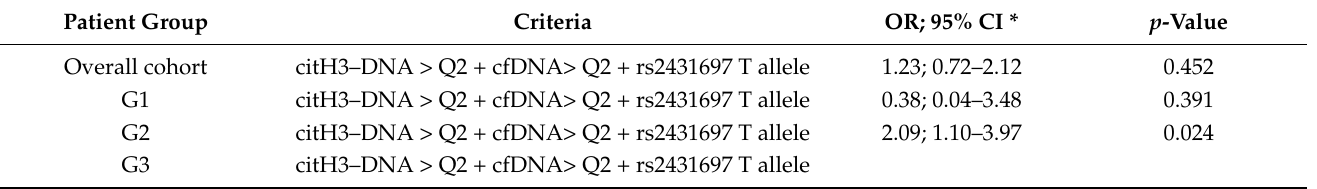
Table 3. Associations of combination of cfDNA, citH3–DNA complexes and rs2431697 with the risk of recurrent ischemic